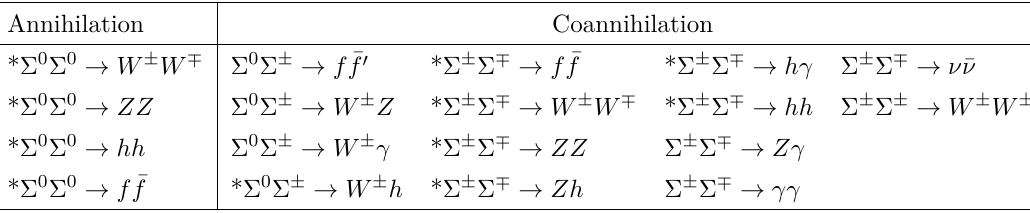
Table 2 . Annihilation and coannihilation processes related to the DM relic density calculation, where f = e, µ, τ, u, d, c, s, t, b and ν = ν e , ν µ , ν τ . Processes starting with an asterisk (*) are a 2